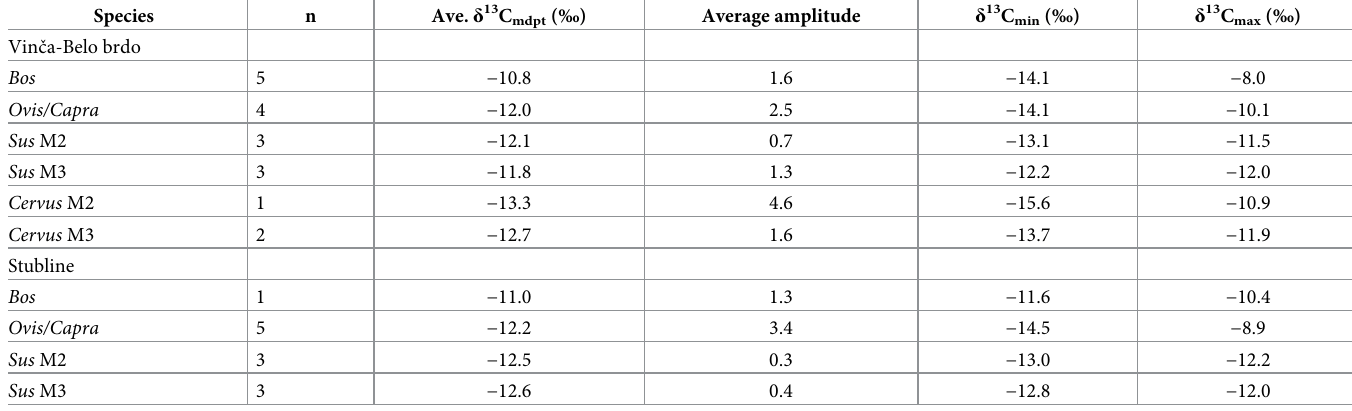
bon isotope value enriched +1.5‰ in 13C relative to other domesticated species. Values from a single cattle tooth from Stubline fell within the range exhibited in cattle from Vin č a-Belo brdo. Table 2. Summary of δ 13 C results from the incremental analysis of cattle ( Bos taurus ), sheep/goat ( Ovis aries/Capra hircus ), pig ( Sus scrofa ), and red deer ( Cervus elaphus ) mandibular teeth. Results for individual teeth are presented in S3